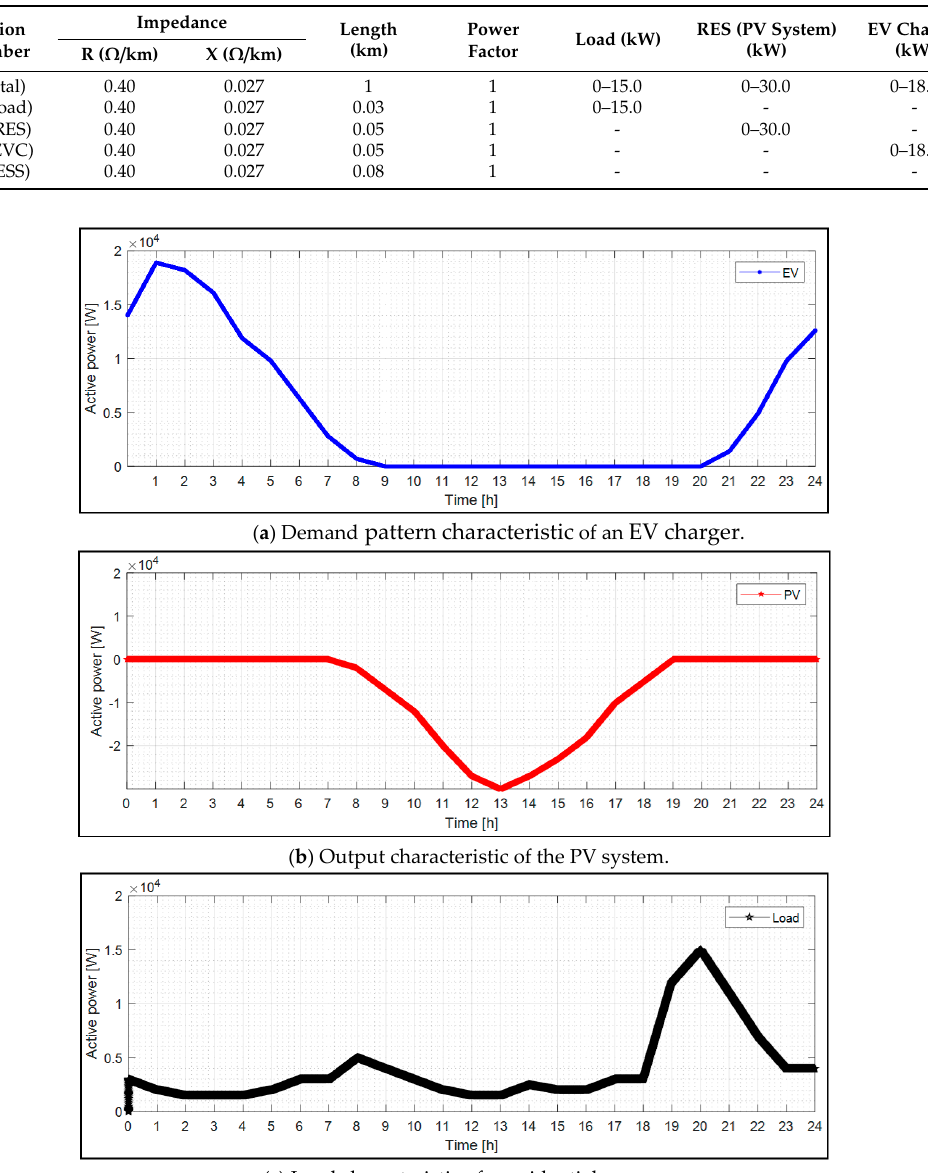
Figure 18. Output pattern of the EV charger, PV system, and customer load.